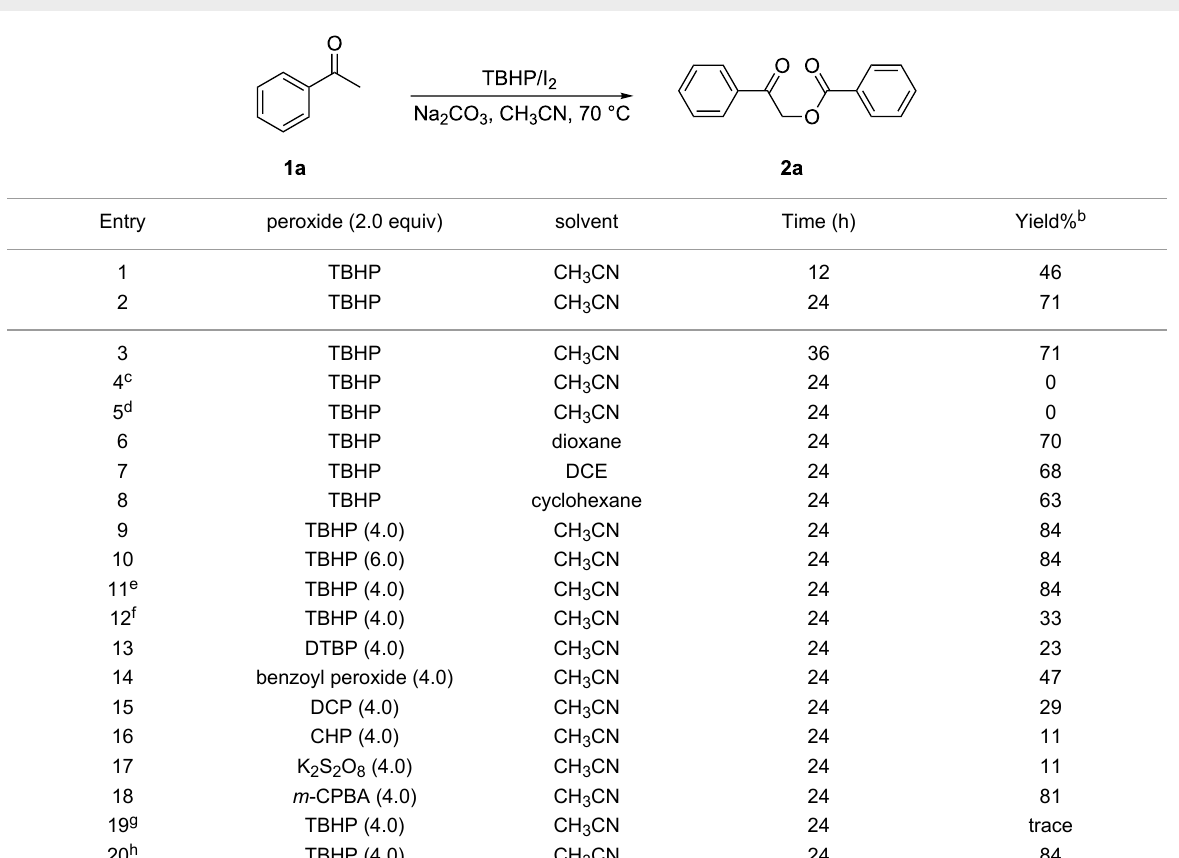
Table 1: Optimization studies a